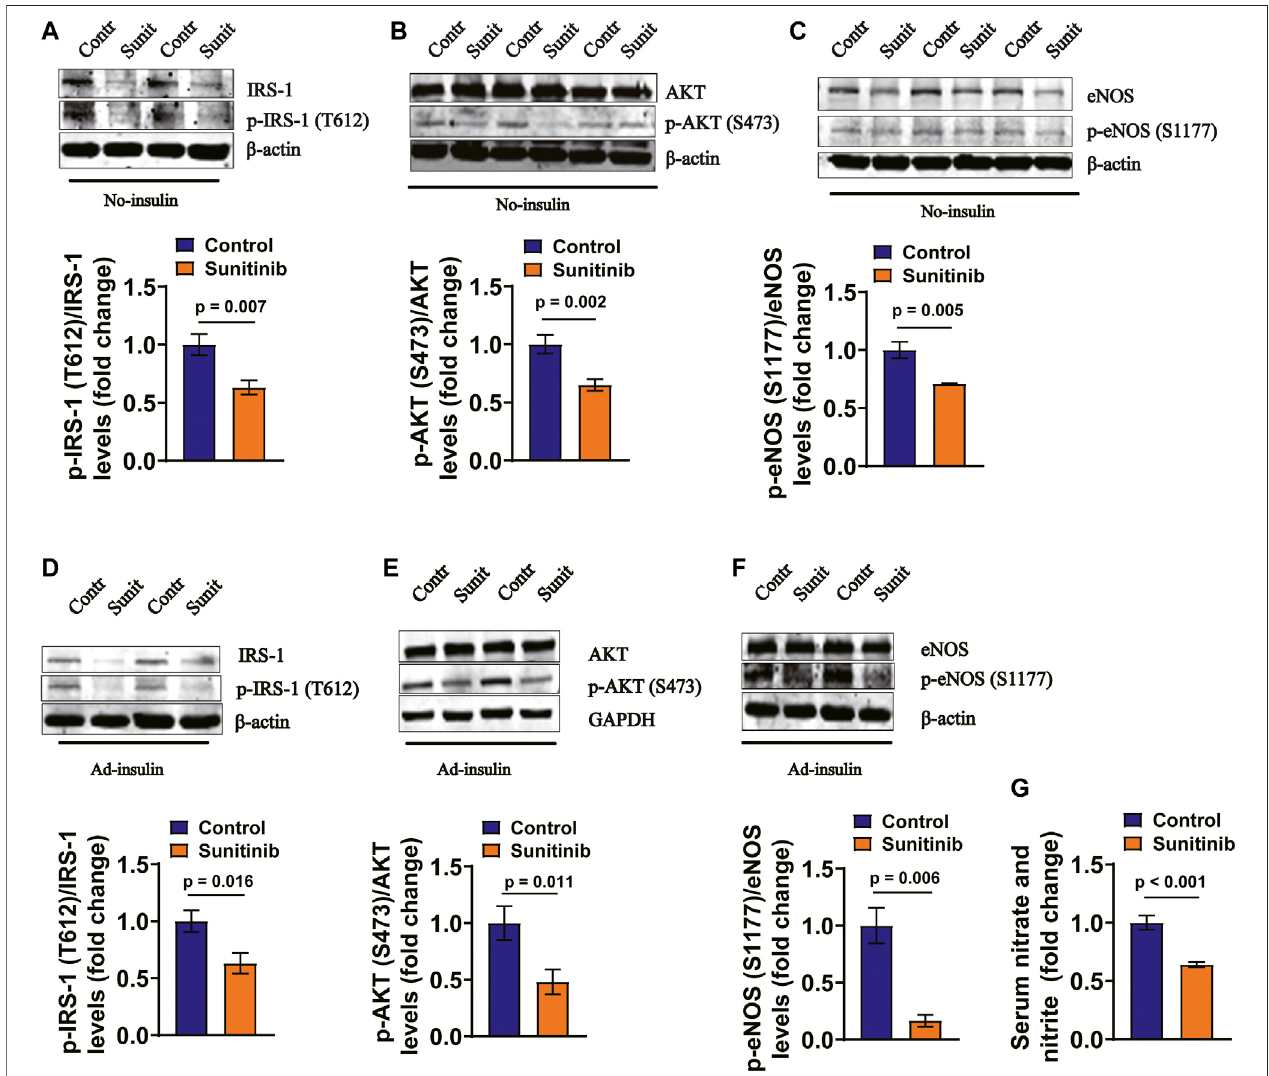
FIGURE 4 | Sunitinib inhibits insulin signaling pathway in mesenteric arteries in rats. (A) Representative western blots of total IRS-1 and phospho-Tyr612 IRS-1 in mesenteric artery tissues isolated on day 7 from control and sunitinib-treated rats, without insulin stimulation; bar graph represents phospho-Tyr 612 IRS-1 levels normalized to total IRS-1 levels (lower panel) ( p (cid:2) 0.007 vs. control; n (cid:2) 6 rats/group). (B) Representative western blots of total AKT and phospho-Ser473 AKT in mesenteric artery tissues isolated on day 7 from control and sunitinib-treated rats, without insulin stimulation; bar graph represents phospho-Ser473 AKT levels normalized to total AKT levels (lower panel) ( p (cid:2) 0.002 vs. control; n (cid:2) 7 rats/group). (C) Representative western blots of total eNOS and phospho-Ser1177 eNOS in mesenteric artery tissues isolated on day 7 from control and sunitinib-treated rats, without insulin stimulation; bar graph represents phospho-Ser1177 eNOS levels normalizedtototaleNOSlevels (lowerpanel) ( p (cid:2) 0.005vs.control, n (cid:2) 7rats/group). (D) RepresentativewesternblotimagesoftotalIRS-1andphospho-Tyr612IRS- 1 in mesenteric artery tissues dissected on day 7 from insulin-injection control rats or insulin-injection rats treated with sunitinib; bar graph represents phospho-Tyr612 IRS-1levelsnormalizedtototalIRS-1levels (lowerpanel) ( p (cid:2) 0.016vs.control; n (cid:2) 7pergroup). (E) RepresentativewesternsoftotalAKTandphospho-Ser473AKTin mesenteric artery tissues isolated on day 7 from insulin-injection control rats or insulin-injection rats treated with sunitinib; bar graph represents phospho-Ser473 AKT levels normalized to total AKT levels (lower panel) ( p (cid:2) 0.011 vs. control; n (cid:2) 12 per group). (F) Representative western blots of total eNOS and phospho-Ser 1177 eNOS in mesenteric arteries dissected on day 7 from insulin-injection control rats or insulin-injection rats treated with sunitinib; bar graph represents phospho-Ser1177 eNOS levels normalized to total eNOS levels (lower panel) ( p (cid:2) 0.006 vs. control; n (cid:2) 6 per group). (G) Serum nitrate and nitrite concentrations were respectively measured on day 7 in control rats or rats treated with sunitinib, re fl ecting NO production in each experimental group ( p < 0.001 vs. control; n (cid:2) 9 per